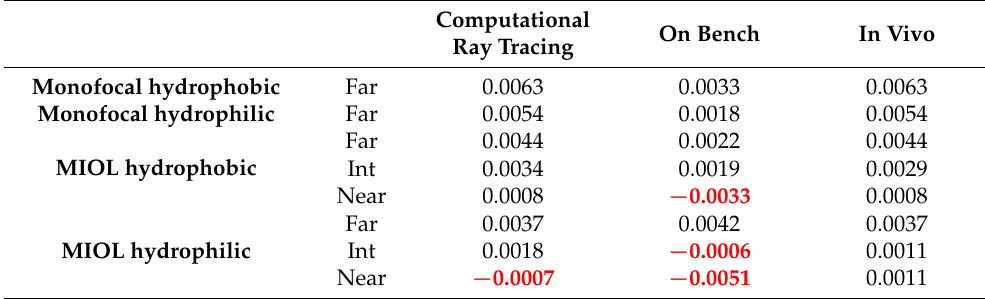
Table 2. Slopes of the linear fittings of the chromatic difference of focus curves for all conditions and IOLs.